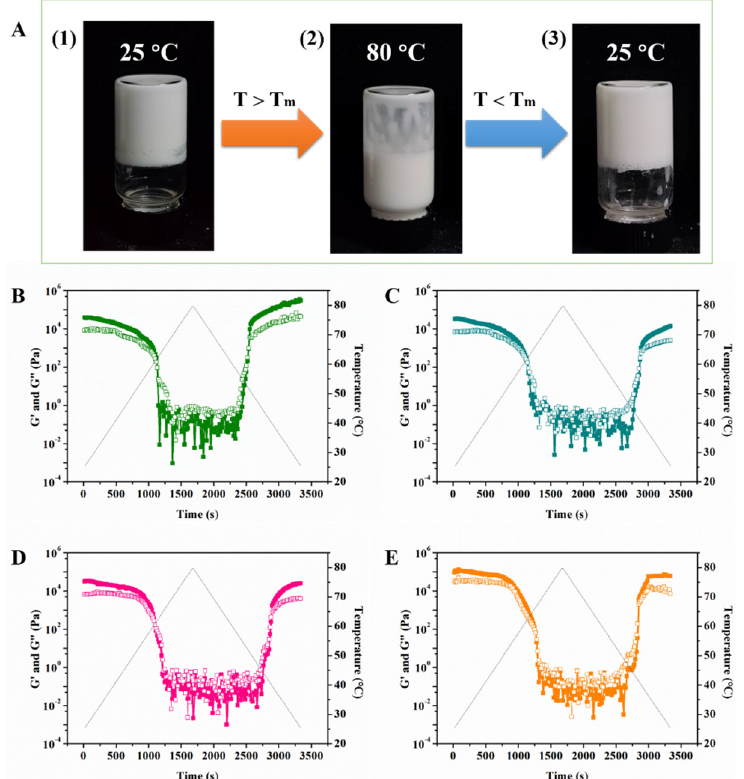
Figure 5. ( A ) Photographs showing the temperature ‐ switchable behavior for a dual ‐ structured gel emulsion with 4 wt% GA nanofibrils and 4 wt% MG: ( 1 ) Stable gel emulsion at 25 °C; ( 2 ) The sample was heated at 80 °C for 5 min, and then the gel emulsion became fluid; ( 3 ) Gelled emulsion was reformed by cooling the system to room temperature (25 °C). Storage modulus (G ′ ) and loss modulus (G ″ ) of dual ‐ structured gel emulsions prepared by 4 wt% GA nanofibrils and different MG concentrations: ( B ) 2, ( C ) 4, ( D ) 8, and ( E ) 16 wt%, measured during the heating and cooling cycles. G ′ and G ″ are shown as filled and open symbols, respectively. All measurements were performed at 25 °C.